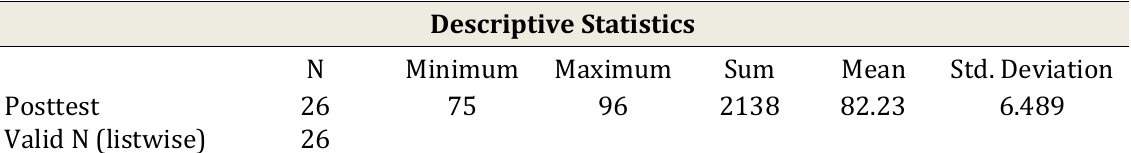
Table 4.4 Mean Score of Students’ in Posttest Re sult